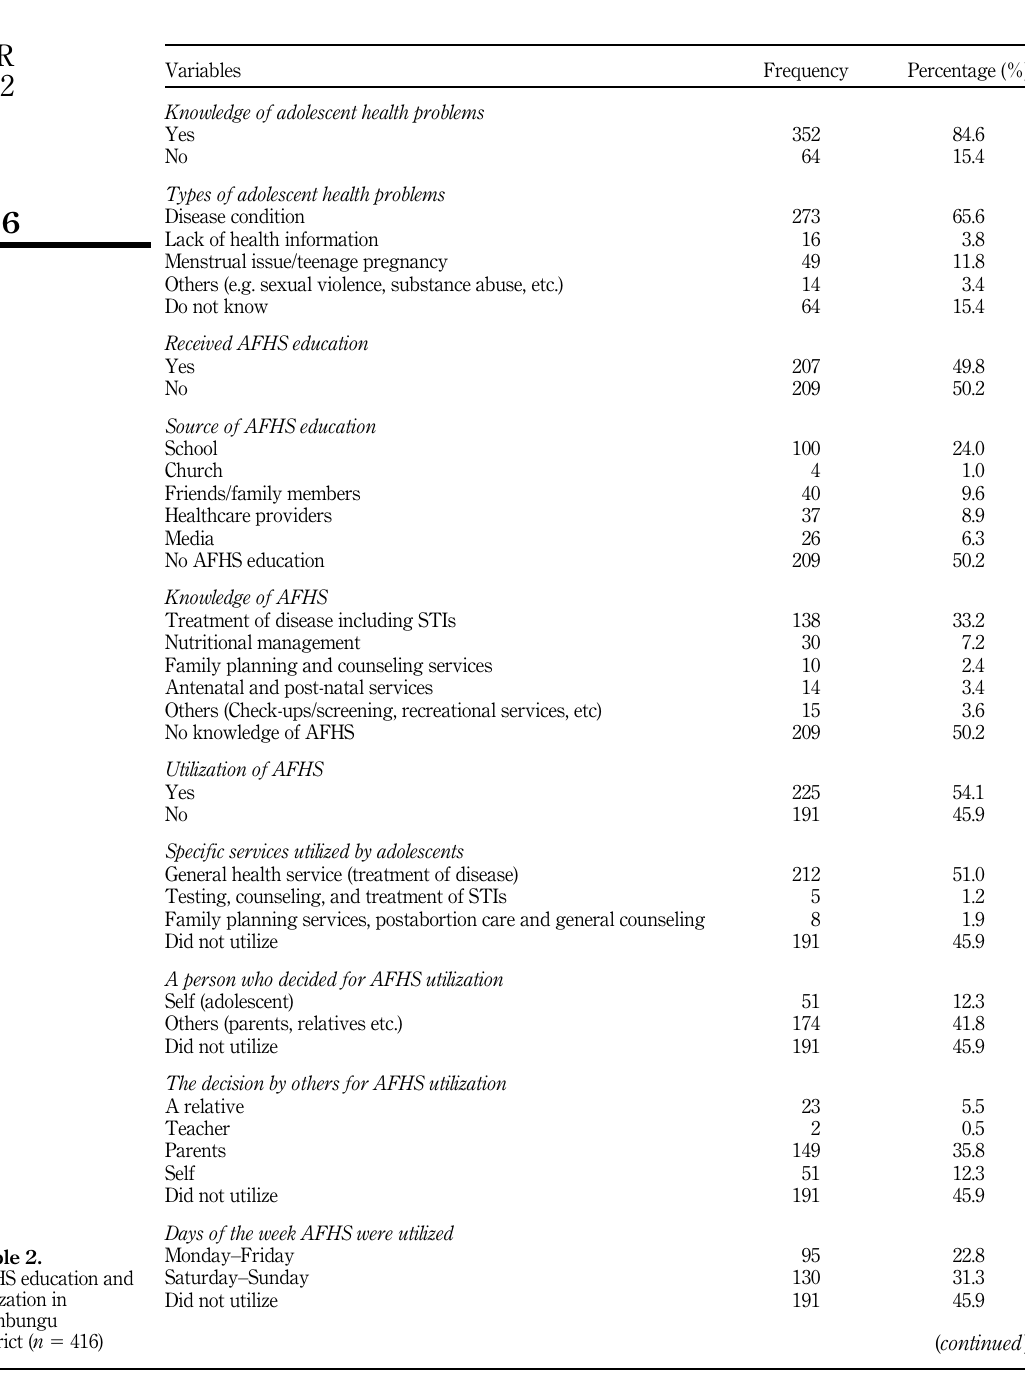
utilization in Kumbungu district ( n 5